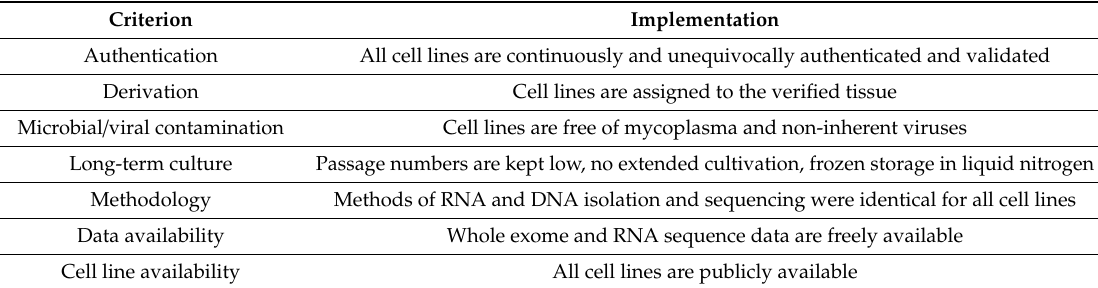
Table 3. Unique Features and Benefits of the LL-100